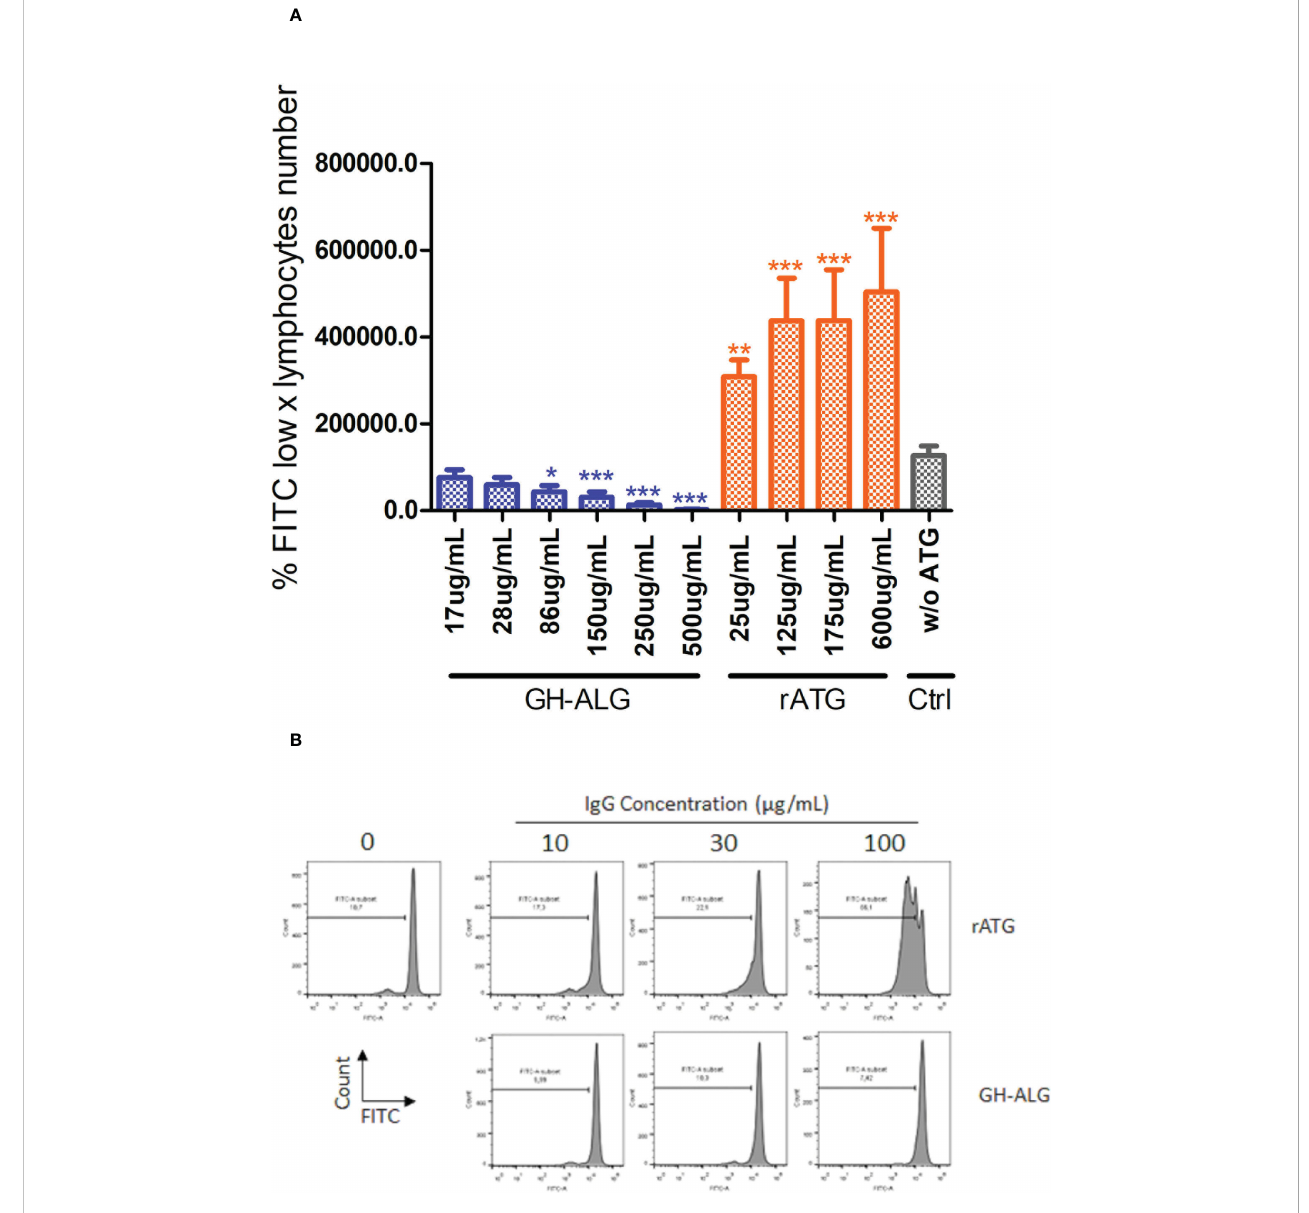
FIGURE 3 Mixed Lymphocyte Reaction assay. (A) Stimulator human PBMCs were irradiated with 35 Gy; responder PBMCs were labeled with CFSE. Stimulator cells were adjusted to 8.106 cells/mL, and responder cells were adjusted to 2 × 106 cells/ml of RPMI medium. Next, the PBMCs were cocultured in a total volume of 200 µl of RPMI medium at 37 °C in a 5% CO2 incubator in the dark for 3 days with or without 250 µg/mL of rabbit ATG or GH-ALG. Proliferation was evaluated by measuring CFSE incorporation using fl ow cytometry. Groups were compared using ANOVA and the Tukey ‒ Kramer multiple comparison test. (B) Representative fl ow cytometry histogram demonstrating serial dilution of FITC. * between 0.01 and 0.05. ** between 0.001 and 0.01. *** between 0 and